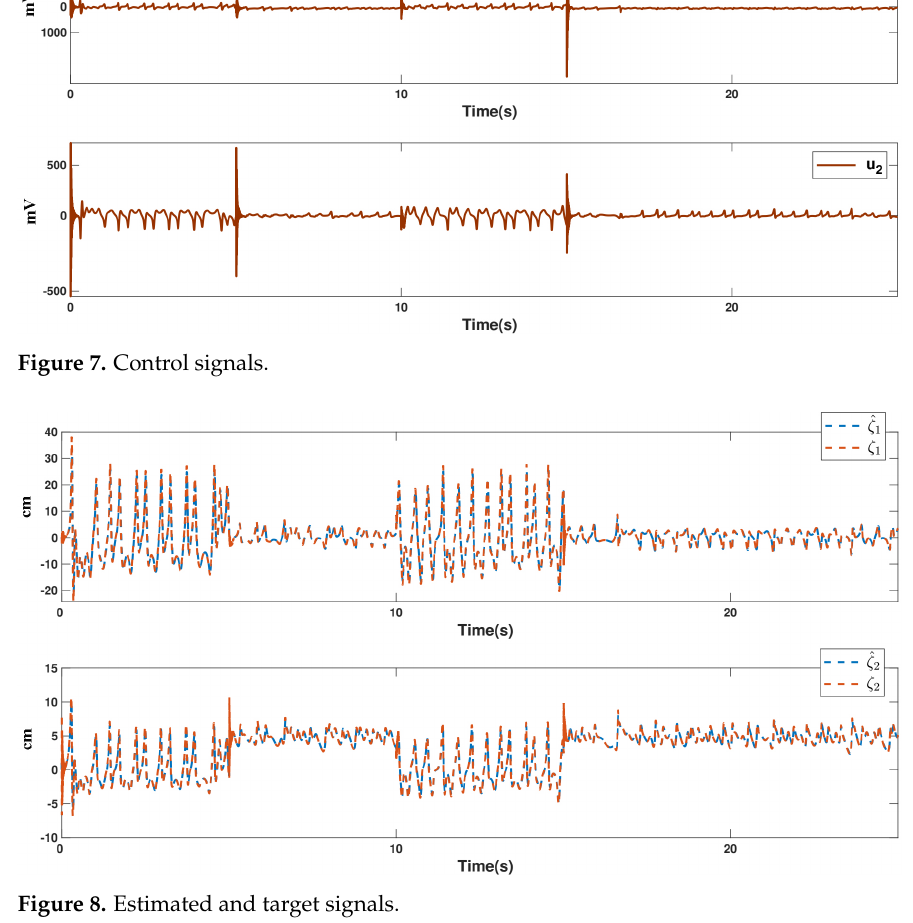
Figure 8. Estimated and target signals.